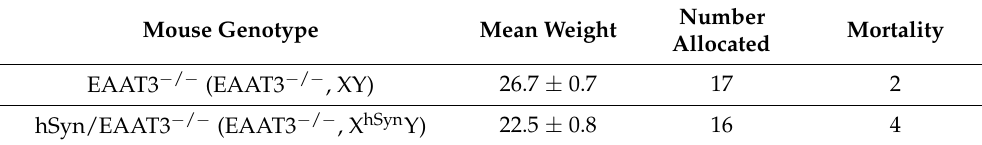
Number Allocated